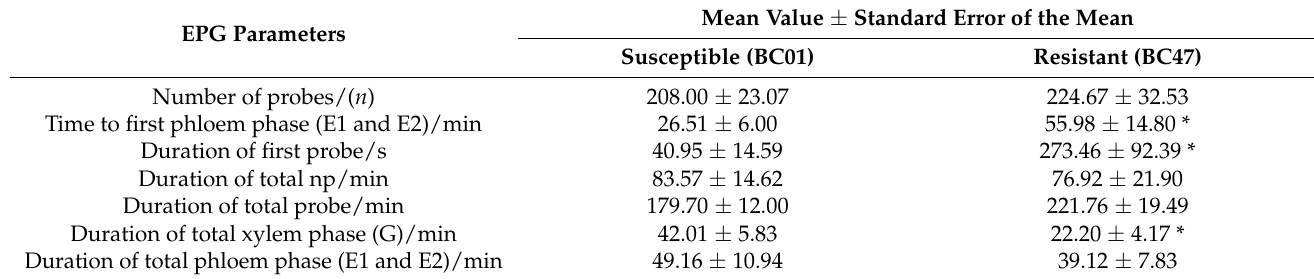
Table 1. The feeding behaviors of aphids on the susceptible and resistant Ethiopia mustard accessions.